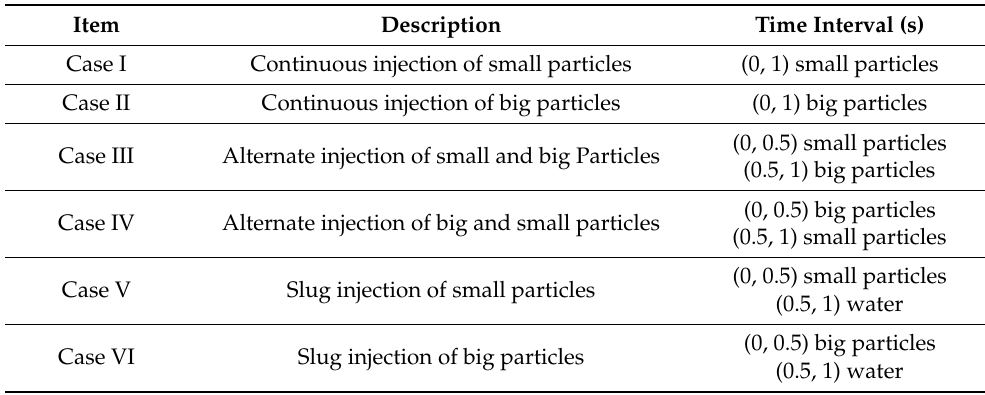
Table 1. Description of different test cases.